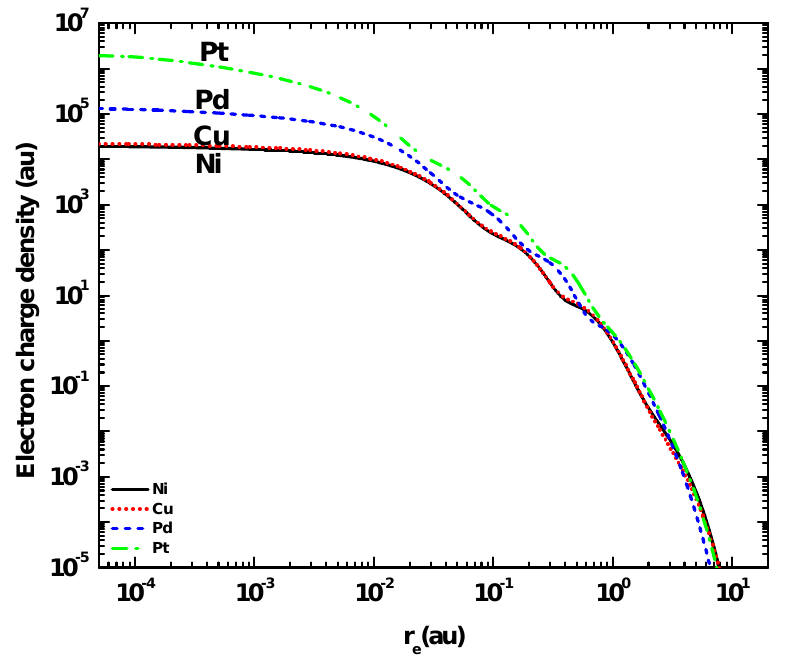
Figure 2. Electron charge density ( (cid:36) e ) for Ni 58 (——, black), Cu 63 ( · · · · · · ) , red), Pd 108 ( − - − -, blue), and Pt 196 ( − · − · − , green) as a function of the distance from the